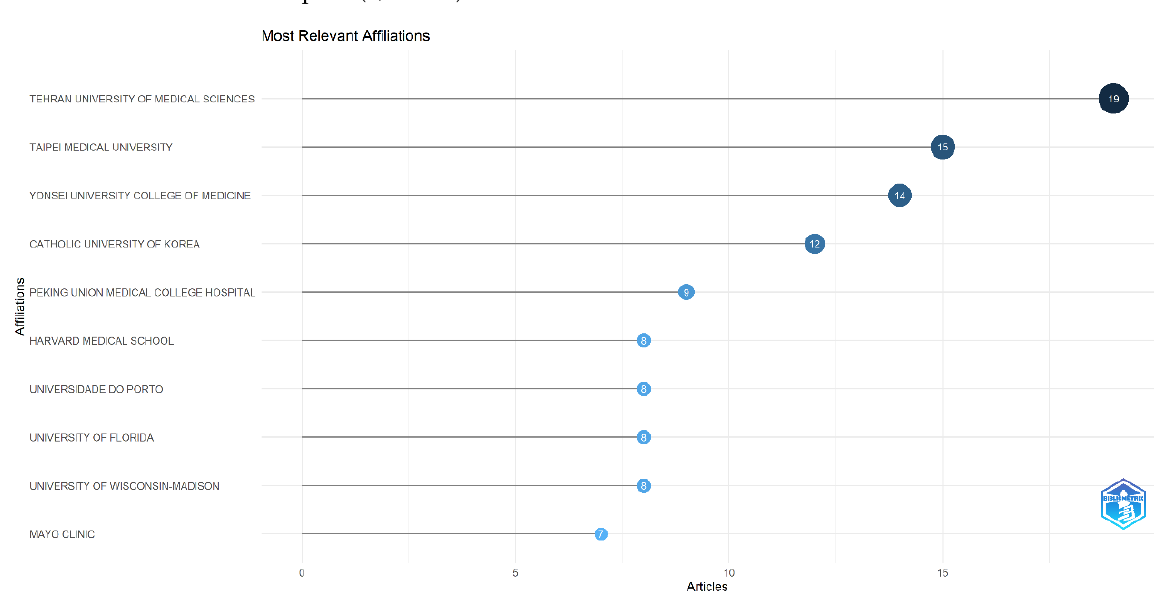
Figure 4. Top 10 institutions performing nutrition research works on sarcopenia.